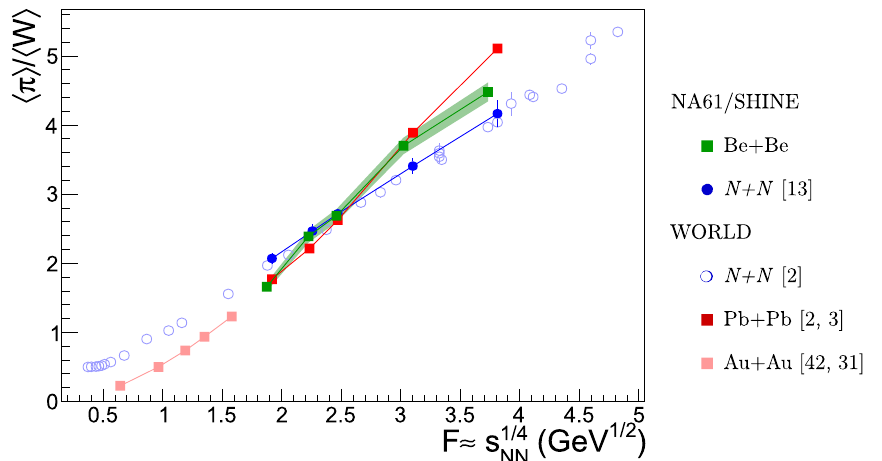
Fig. 20 The “kink” plot showing the ratio of pion multiplicity (cid:4) π (cid:5) to number of wounded nucleons (cid:4) W (cid:5) versus the Fermi energy vari- / 4 able F ≈ s 1 . Results from central Be + Be collisions are NN compared to measurements in inelastic nucleon–nucleon reactions